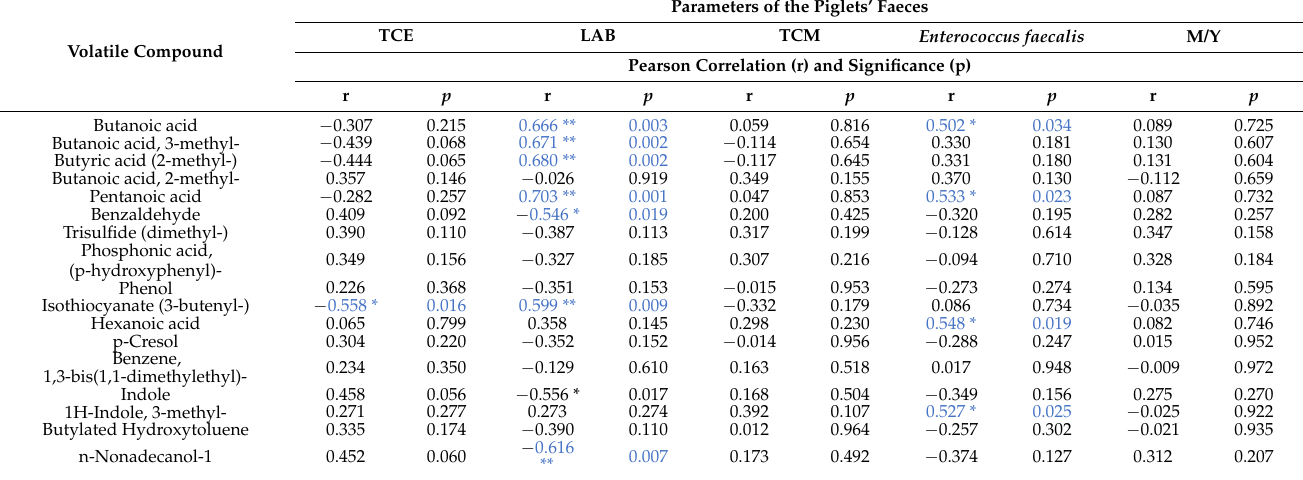
Table 8. Correlations between piglets’ faecal volatile compounds and other